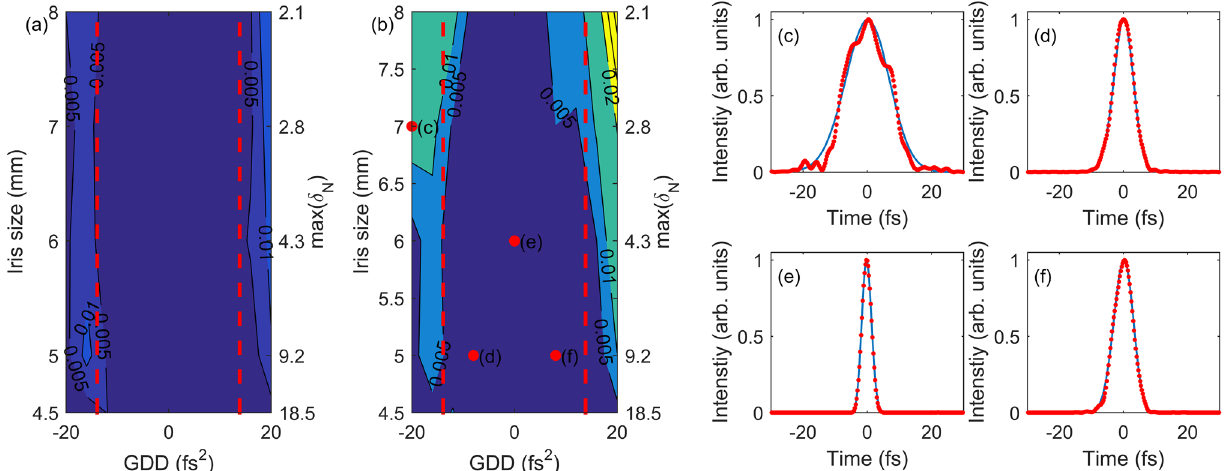
Figure 4. Reconstruction results obtained using chirped Gaussian pulses for different maximum NIYs and GDDs. ( a ) Normalized differences obtained using Gaussian pulse without noise. ( b ) Normalized differences with 1% NRMS power fluctuation of a laser pulse. The duration of the laser pulse was 3.3 τ TL at a GDD of 13.9fs 2 , as shown with red dashed lines in ( a ) and ( b ). ( c – f ) Intensity profiles of the original laser pulse (blue ± line) and reconstructed intensity profiles (red dots) obtained at the conditions denoted with red circles in ( b